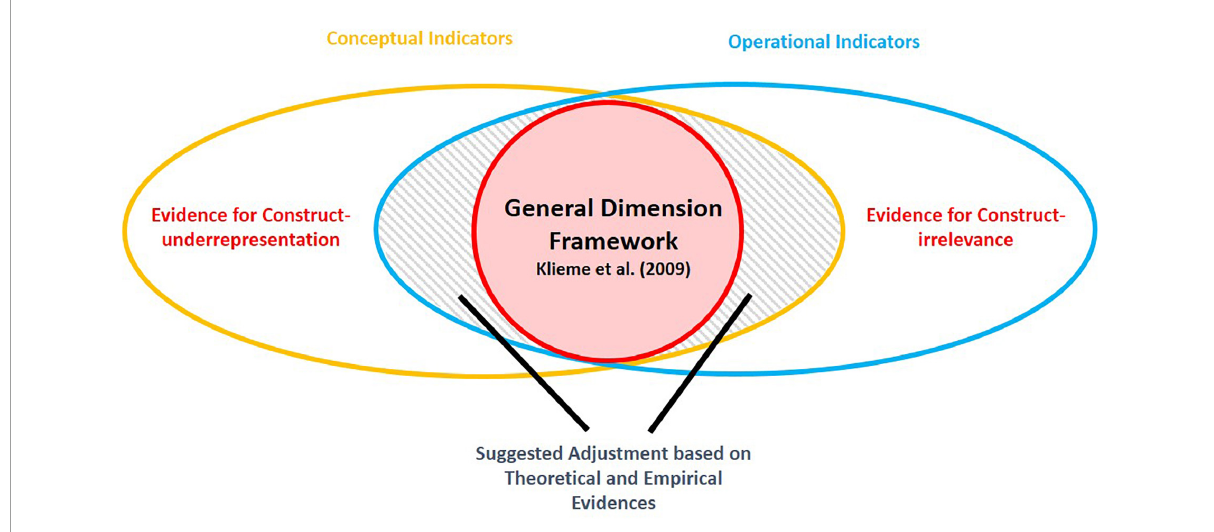
FIGURE1 Visualization of the main concepts of the study.